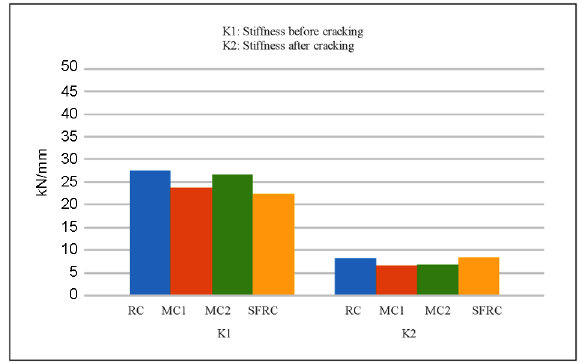
Fig. 6. Average stiffness before and after cracking of beams tested